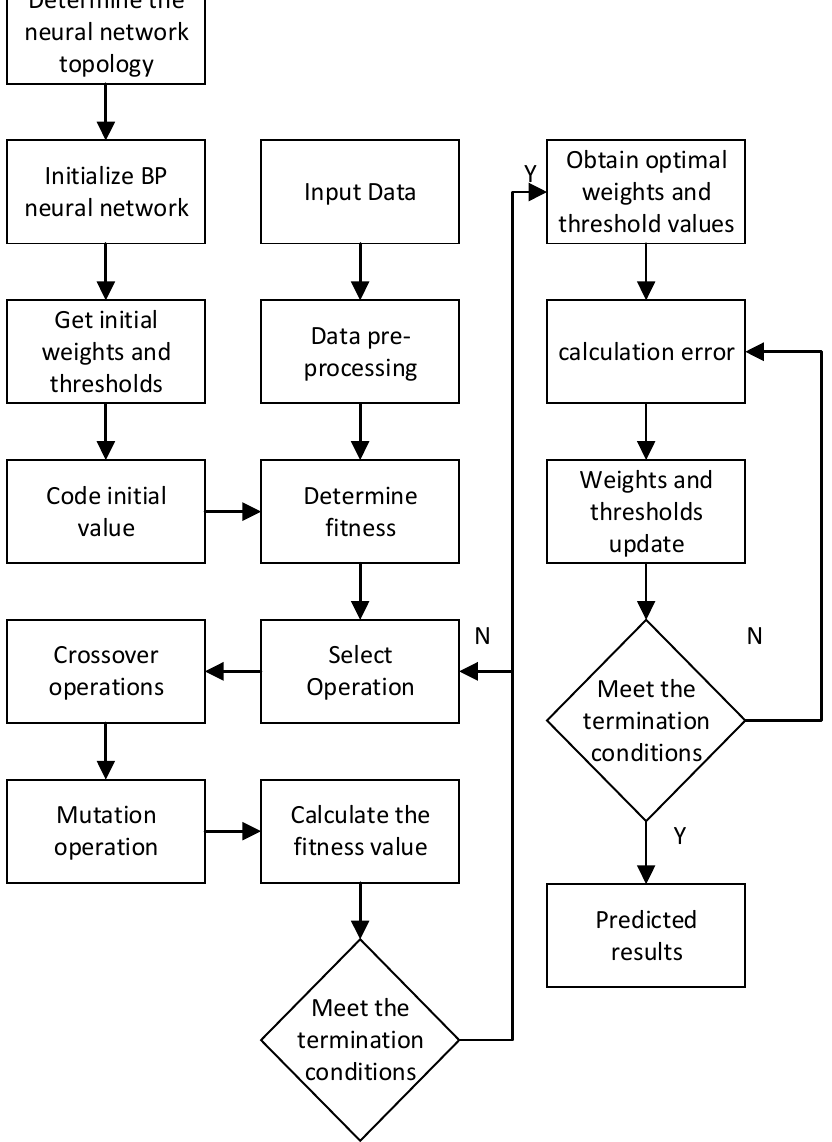
Figure 3. Flow chart of GA-BP neural network based on multi-parameter fusion for mud overflow and leakage prediction.